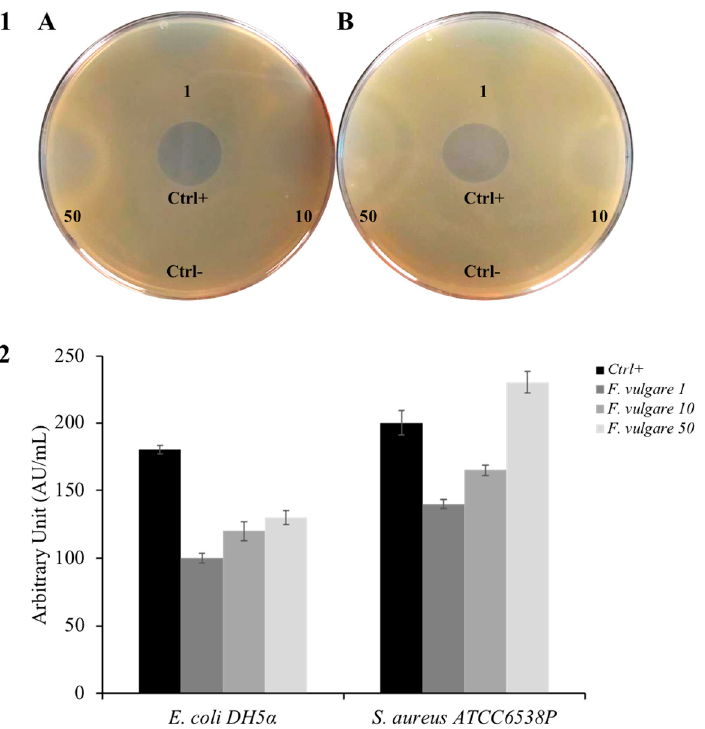
Figure 2. Kirby-Bauer assay. Panel 1 shows the inhibition halo of F. vulgare subsp. vulgare var. vulgare against ( A ) E. coli and ( B ) S. aureus. Panel 2 shows the inhibition halo expressed in AU/mL. Values are expressed as the average of three biological replicates; standard deviations are always less than 10%.